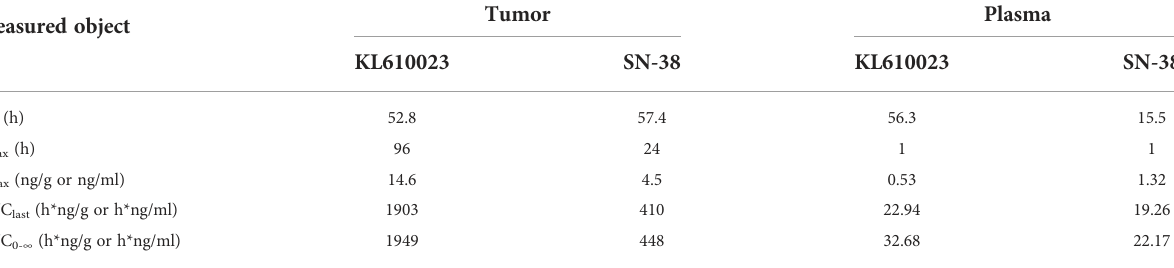
TABLE 4 Payload pharmacokinetic parameters in tumor and plasma after administration of either SKB264 or IMMU-132 in tumor-bearing mice (mean, n = 5). Measured object